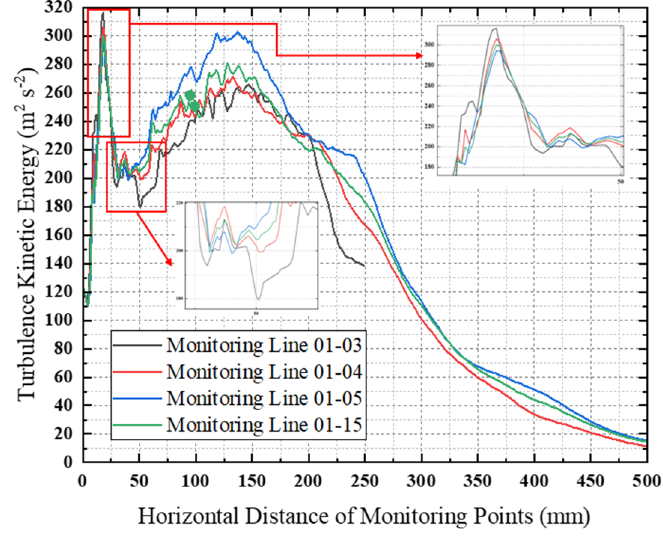
Figure 12. Turbulent kinetic energy of the standard nozzle flow field with a compressed air pressure of 212,782 Pa and a temperature of 303 K.